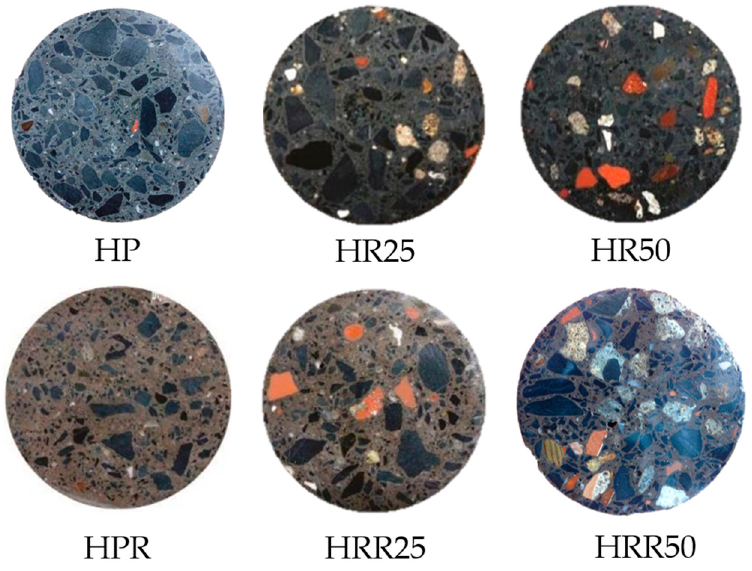
Figure 8. Oxygen permeability coefficient ( a ) and water penetration depth ( b ).